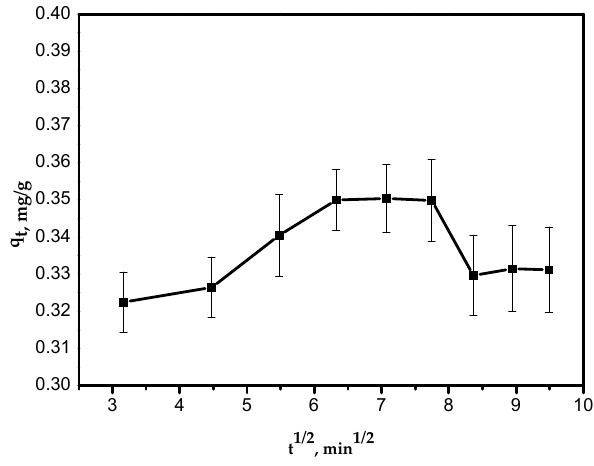
Figure 8. Intra-particle diffusion kinetic model. Figure 8. Intra ‐ particle diffusion kinetic model. Table 2. Kinetic parameters of the removal of Pb(II) ions from aqueous solutions by AILP.